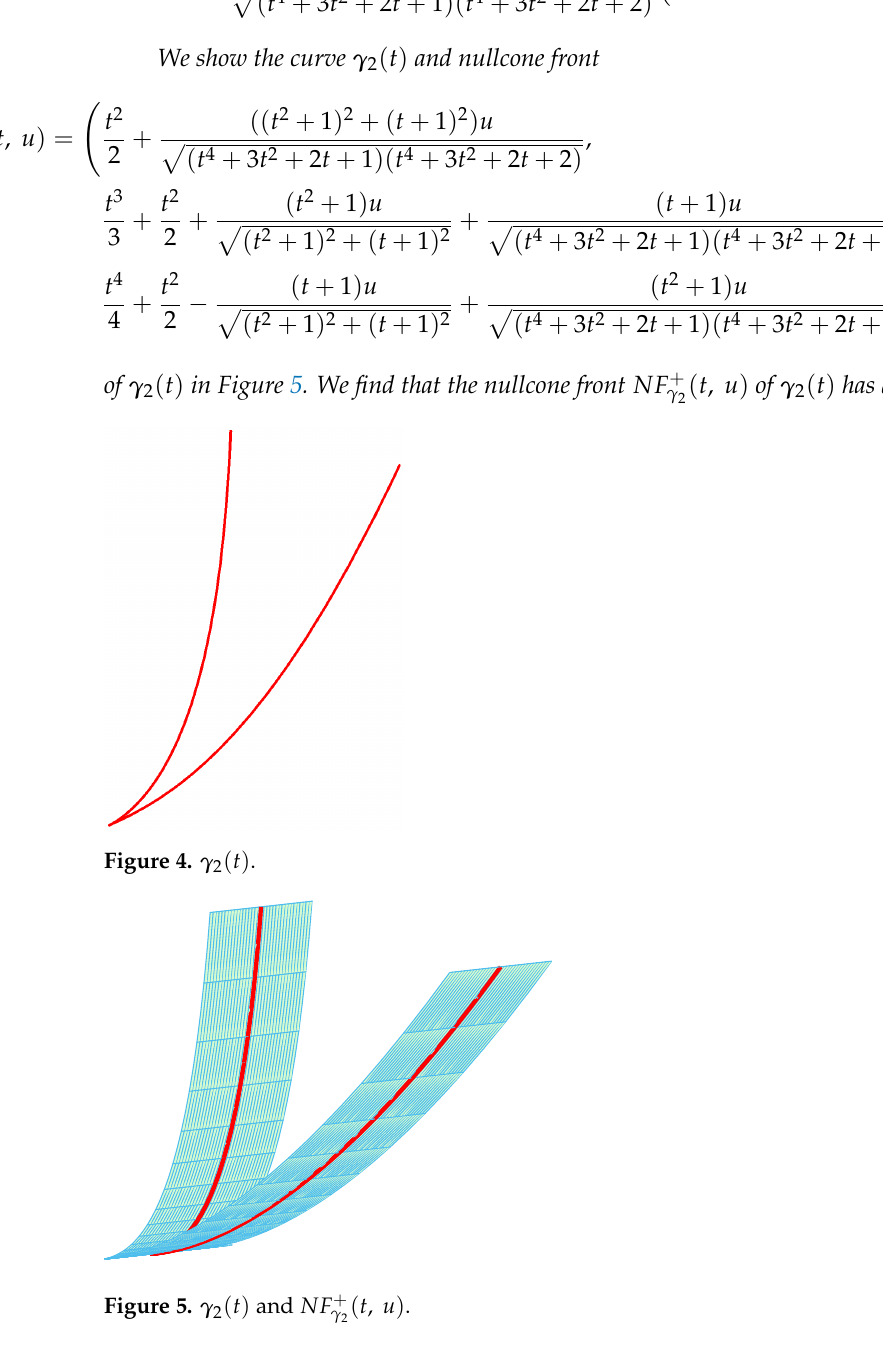
Figure 5. γ 2 ( t ) and NF + γ